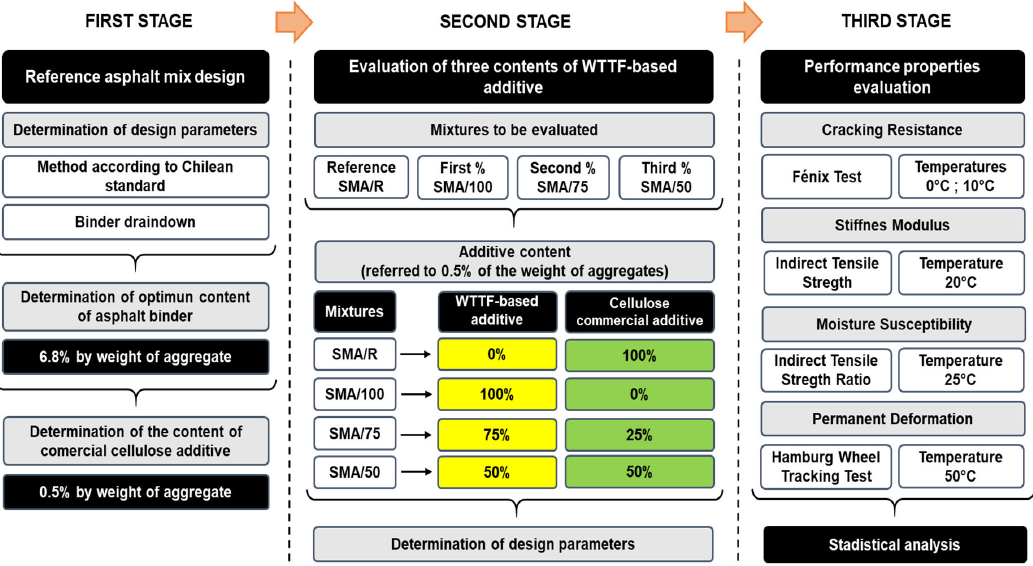
Figure 7 . Experimental stages used in the study. Figure 7. Experimental stages used in the study.